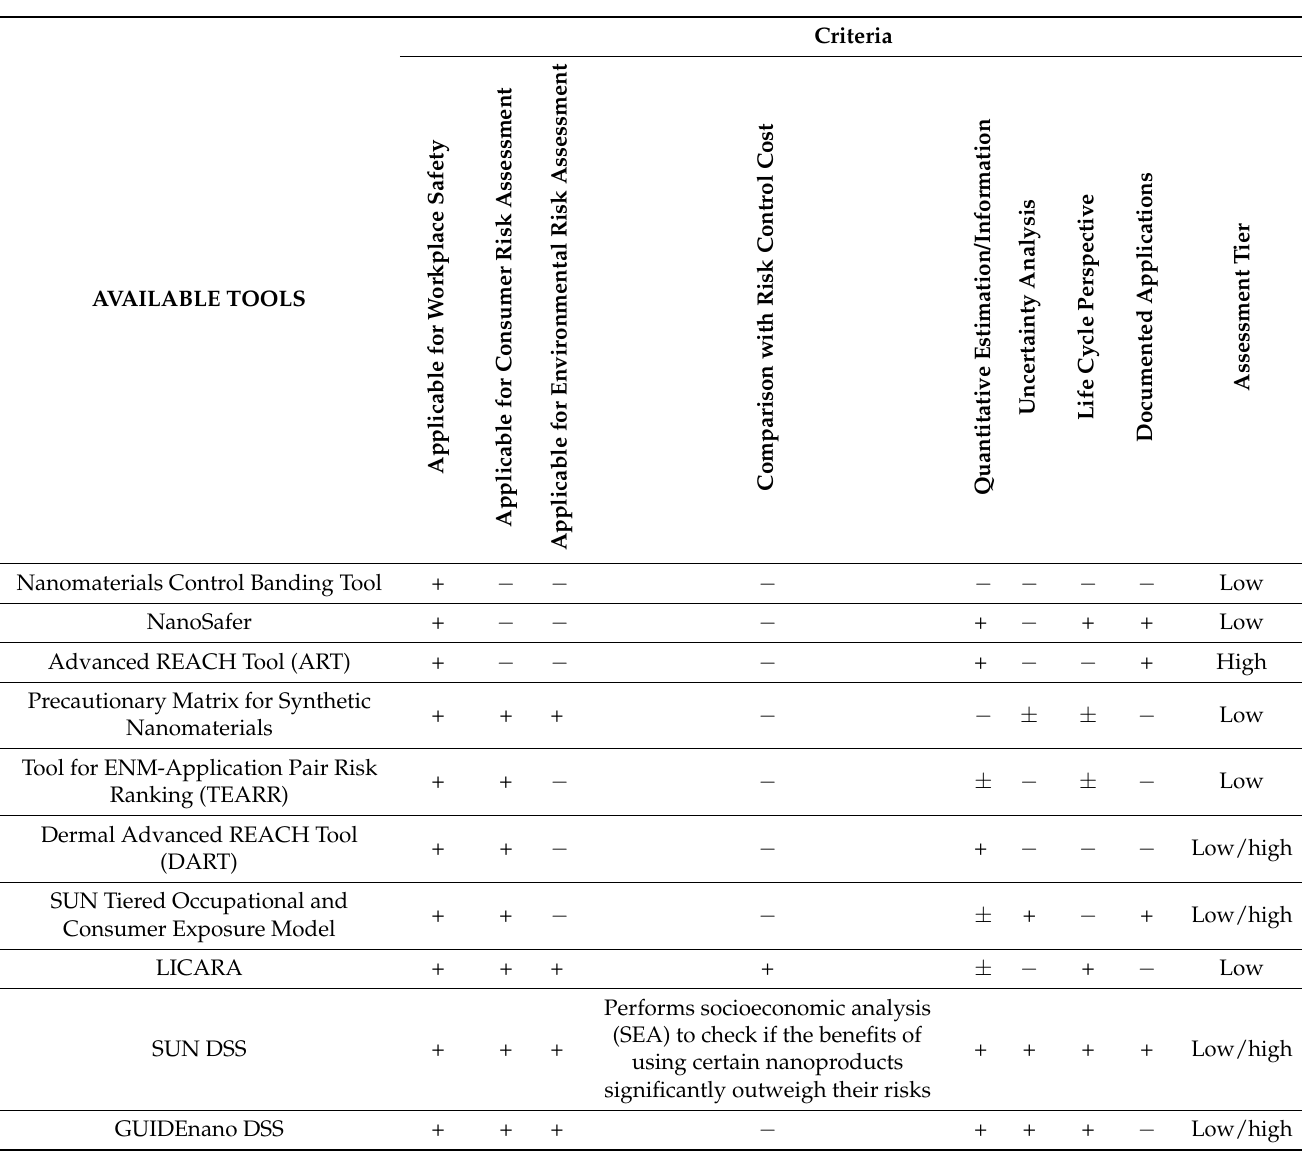
Table A1. Most cited models to assess exposure and manage risk when dealing with nanomaterials and nano-enabled products.